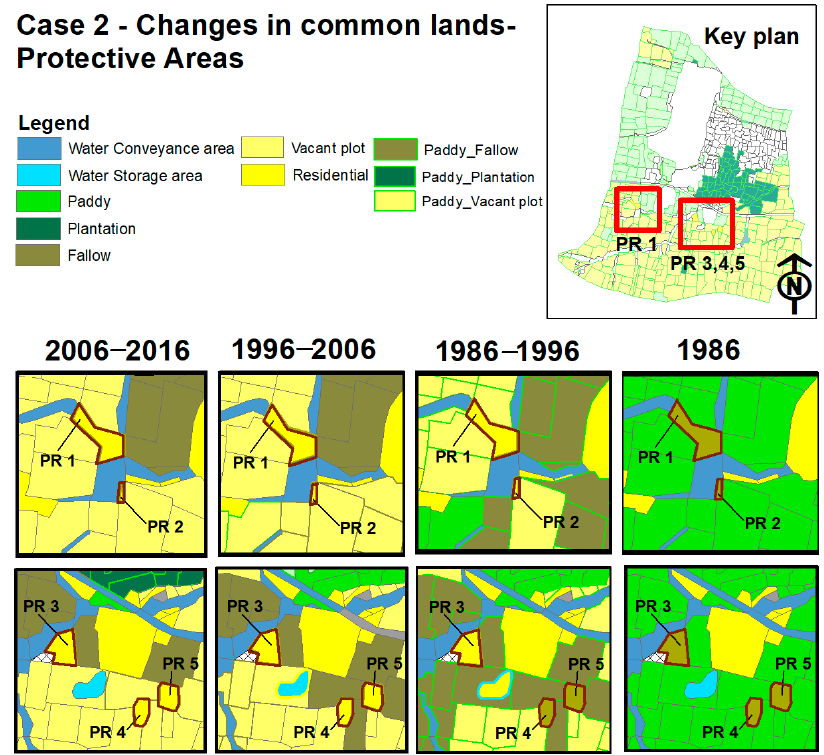
Figure A3. Trajectories of change: Case 2—protective area.